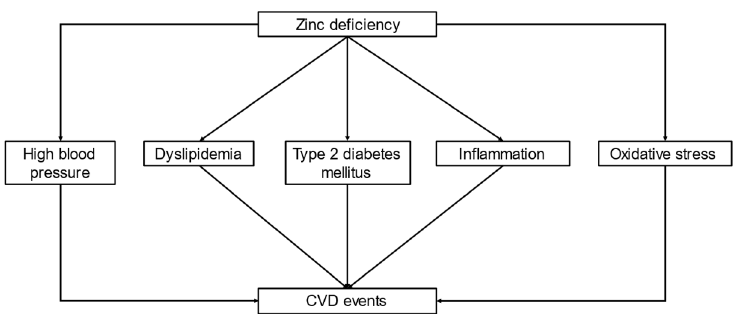
Figure 2. Association of zinc deficiency. Zinc deficiency is associated with major risk factors for CVD, including higher blood pressure, dyslipidemia, type 2 diabetes mellitus, inflammation, and oxidative stress. Zinc deficiency is associated with CVD events in CKD patients, including those undergoing hemodialysis. Abbreviations: CKD, chronic kidney disease; CVD, cardio vascular dis- ease.